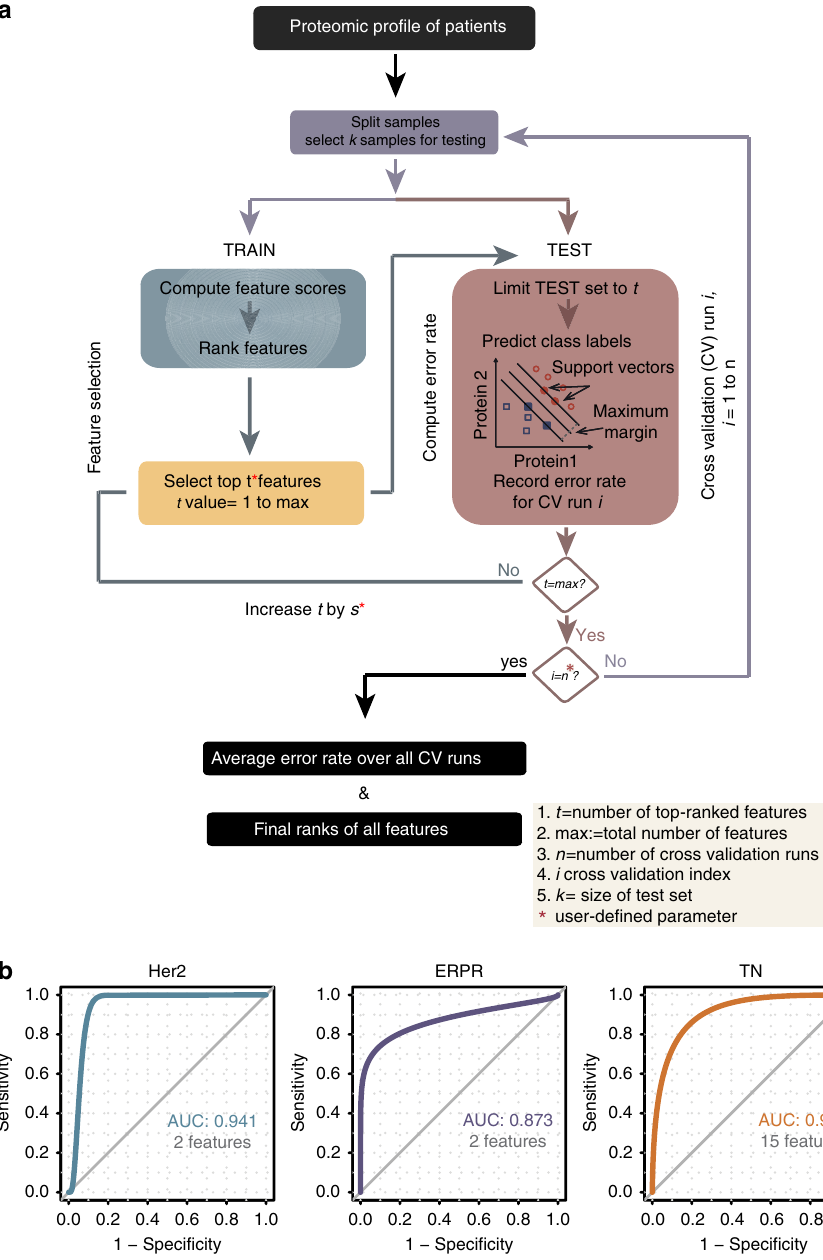
Figure 5 | Computational workflow of feature selection in breast cancer patients. ( a ) To establish a predictive classifier of breast cancer subtypes, we developed a workflow that embeds classification and feature selection in a random sampling cross-validation procedure. In this framework, the user can define the fraction of samples to be randomly selected for the test set, as well as the number of such random samplings. The features in the training set are then ranked based on a pre-defined scoring scheme. Next, the predictive power of sets of ranked features of different sizes is computed in the test set and recorded for each cross-validation run. ( b ) Receiver operating characteristics (ROC) curves are given for each of the three predictors built using the optimal number of selected features. The performance of the predictors is shown by the area under curve (AUC) and ranges from 0.87 for the ERPR subtype to 0.94 for the Her2 positive